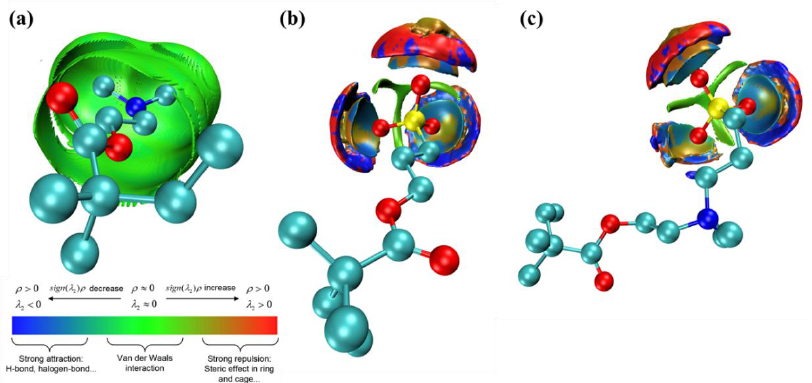
Figure 12. Noncovalent interaction around three different nonfouling repeat units. ( a ) DM, ( b ) SP, ( c ) SB.